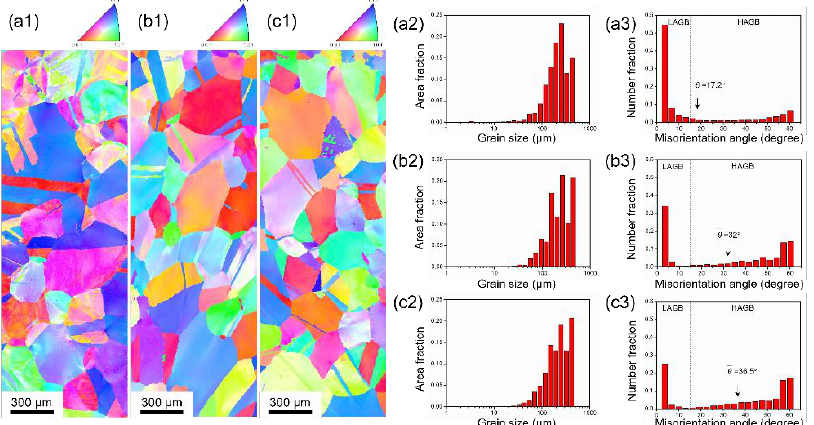
Figure 5. ( a1 , b1 , c1 ) The EBSD maps of the regions close to the fracture surfaces at room temperature, 700 °C, and 750 °C, respectively, ( a2 , b2 , c2 ) corresponding grain size distribution behavior, ( a3 , b3 , c3 ) corresponding grain boundary misorientation angle distribution